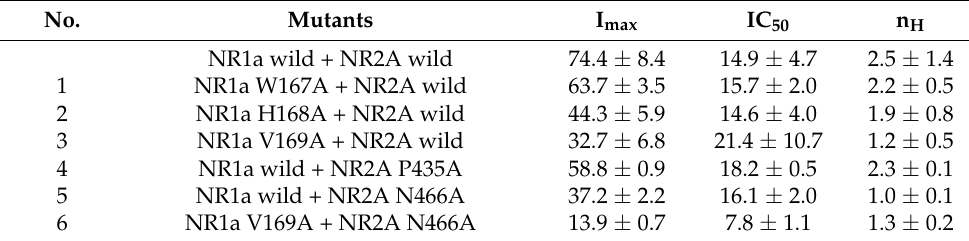
Table 3. Effect of ergotamine on the glutamate-evoked current of wild-type NR1a/NR2A receptor and its various